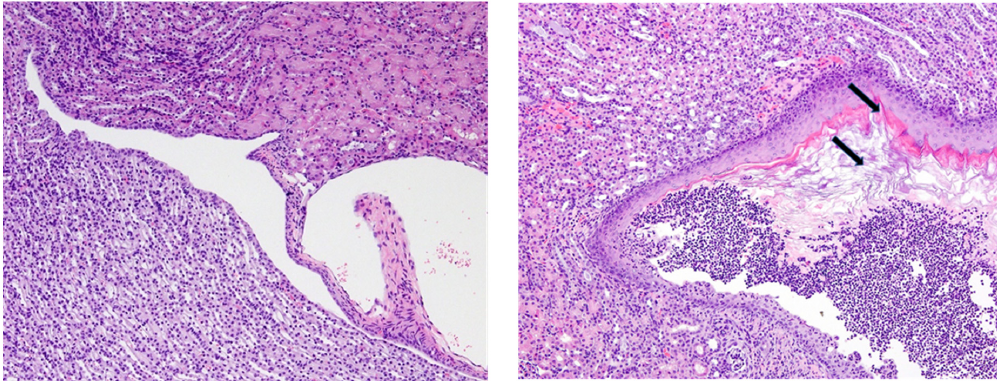
Figure 3. Histopathologic analyses of epithelial changes and inflammation in the renal pelvis and cortex of mice on vitamin A deficient (VAD) diets. Mice were injected with complete Freund’s adjuvant followed by incomplete Freund’s adjuvant approximately 3 weeks later and sacrificed approximately 3 – 4 weeks after the second injection. Representative tissue sections are shown (10× magnification). (Left) a mouse on the normal control diet. The urothelium lining the renal pelvis and fornices consisted of a thin layer (1 – 3 cells thick) of polygonal cells with clearly defined nuclei. (Right) in a VAD mouse, there was marked thickening of the squamous epithelium, with the cornification of upper layers (top arrow) and the extensive sloughing of cornified cells into the lumen of the renal pelvis (bottom arrow).